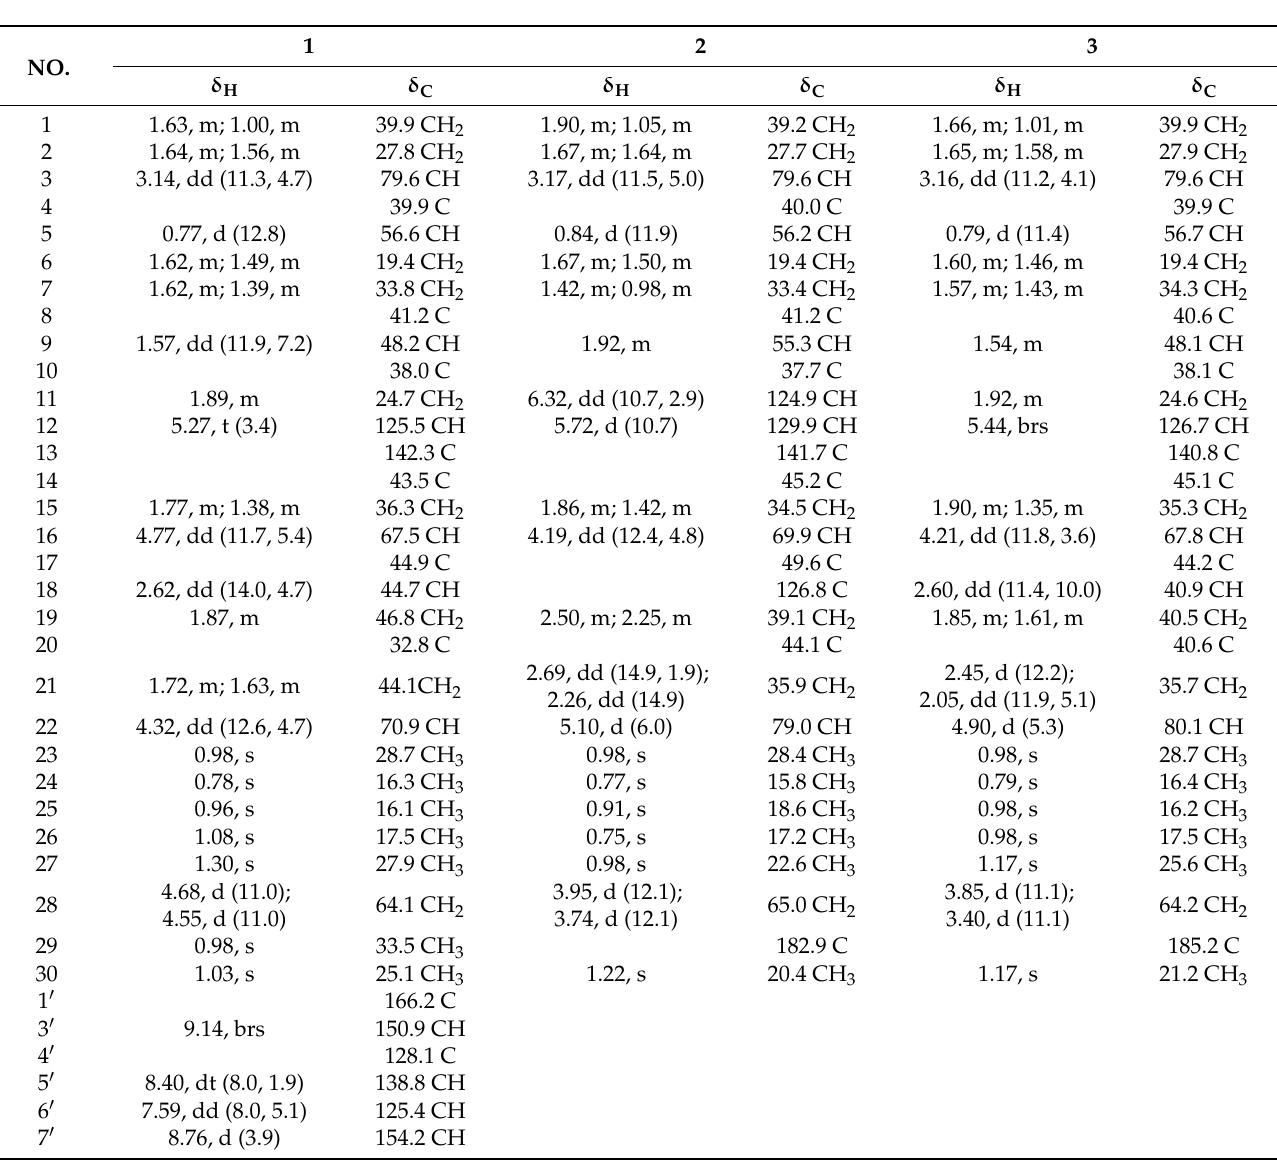
Table 1. 1 H NMR and 13 C NMR Data (500 MHz, CD 3 OD) of 1 − 3